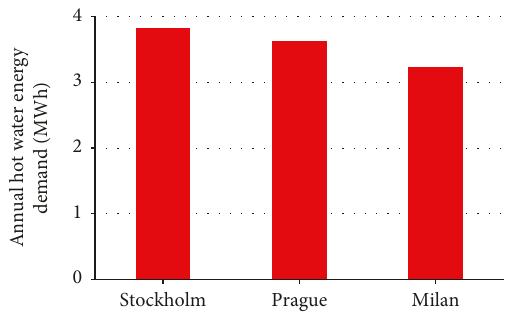
Figure 10: Hot water heating demand for given locations.